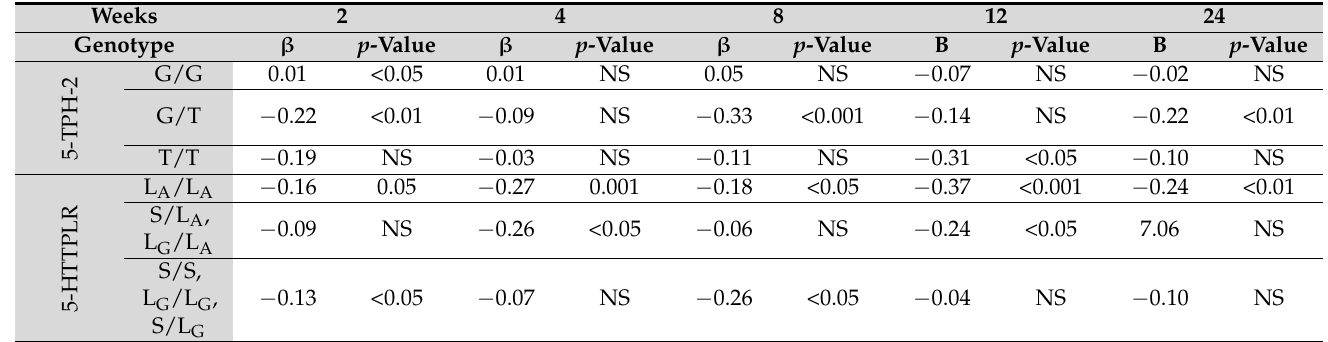
Figure 5. Changes in tryptophan concentration for functional 5-HTTPLR genotype groups of L A /L A ; S/L A and L G /L A ; and S/S, L G /L G , and S/L G during PEG-IFN- α 2a/RBV treatment. Table 5. Multilevel regression analyses indicating differences in tryptophan concentration for each time point compared to baseline, with β indicating regression coefficient and p the level of significance for patients with genotypes of TPH-2 and functional 5-HTTPLR.